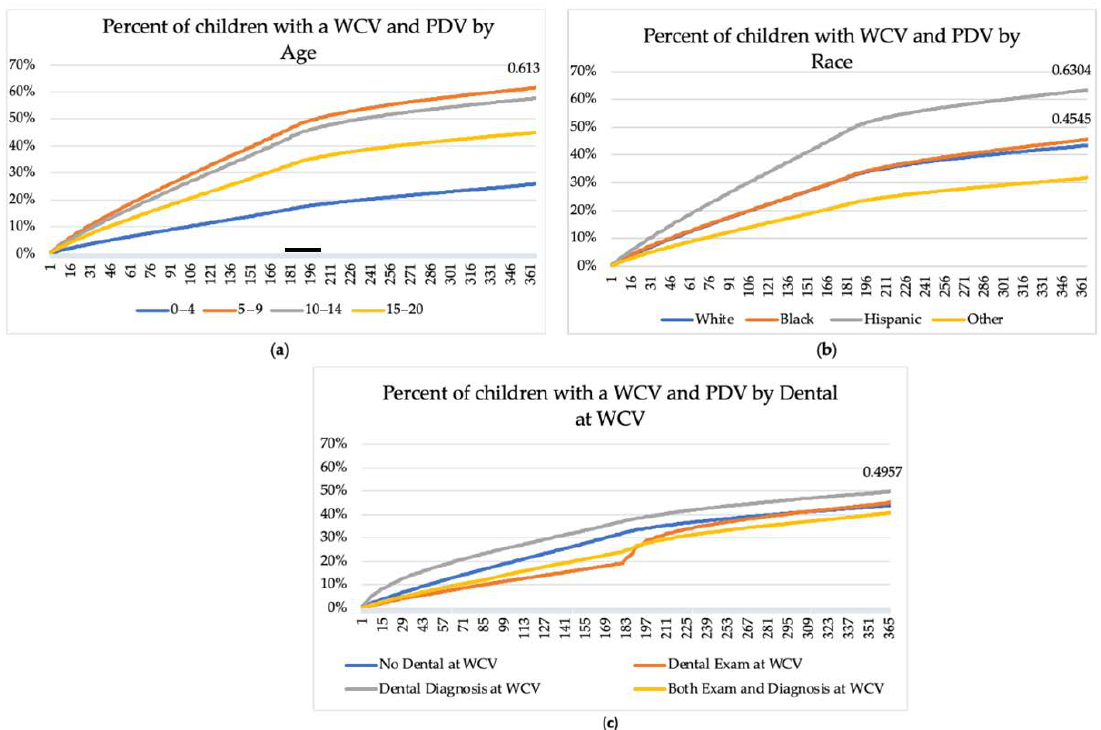
Figure 3. Percentage of children with a Well-Child Visit (WCV) followed by a Preventive Dental Visit (PDV) across 365 days, by age ( a ) and by race ( b ) and any dental ( c